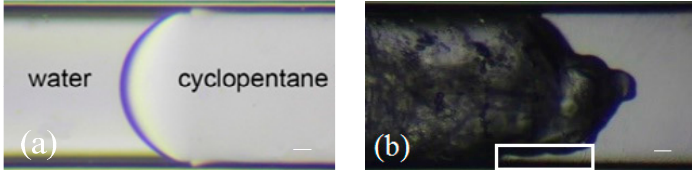
Figure 3. Formation of CP hydrate and ice in the capillary, the scale bars in the images correspond to 50 μ m.